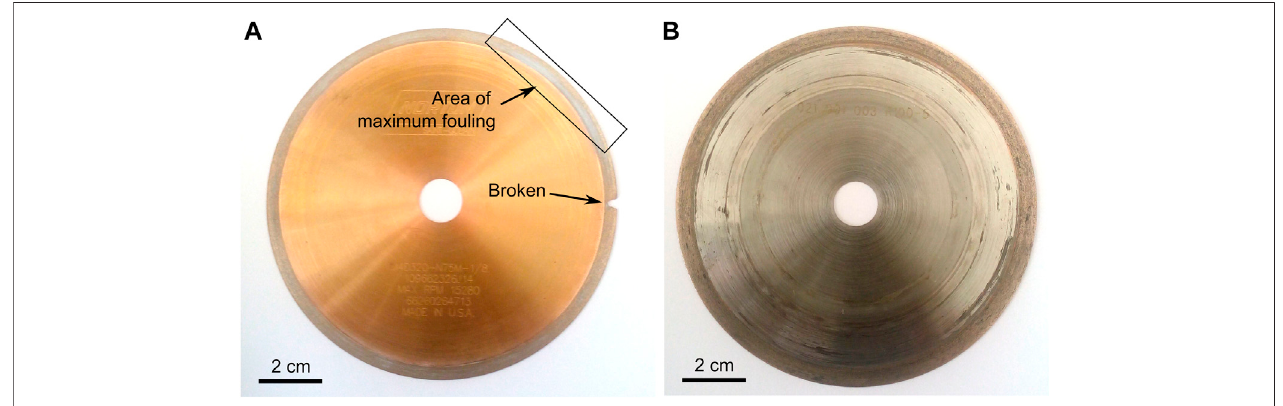
FIGURE5| Discsaftercuttingtests. (A) NC100discusedtocutthechalkwiththePresiP100discsaw. (B) R100-5discusedtocutthechert,thekomatiiteandthe basalt with the Struers Secotom-10 disc